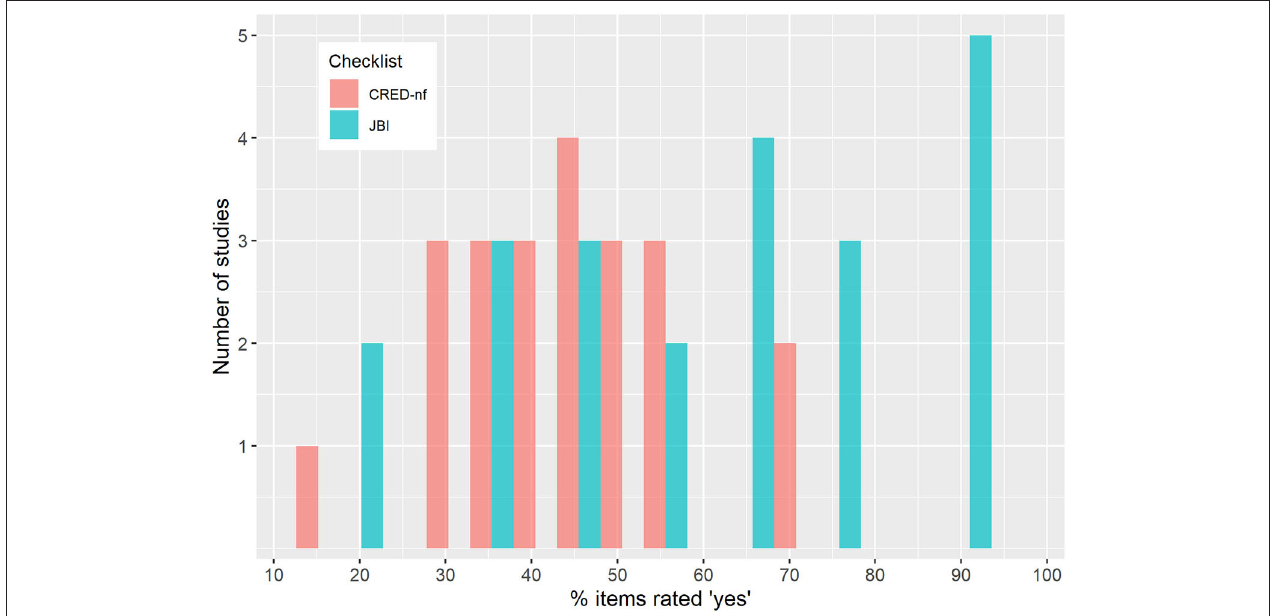
FIGURE 5 | Quality of studies according to the CRED-nf and JBI